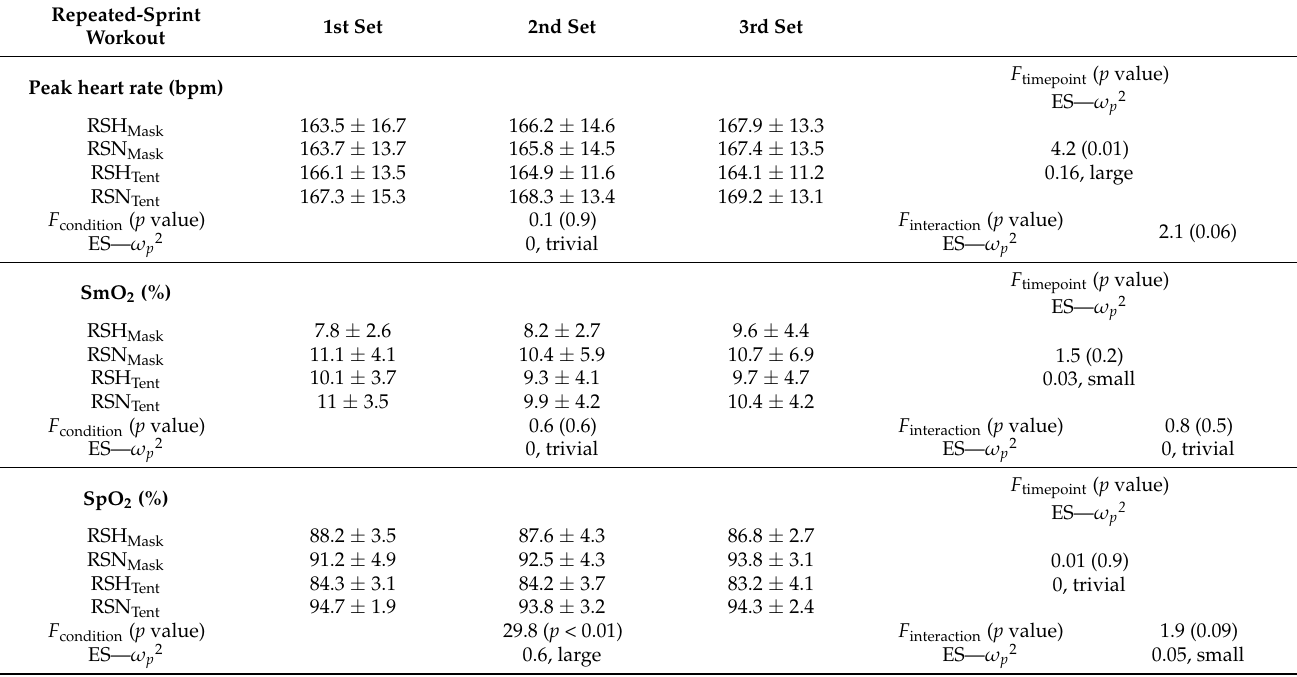
Table 1. Changes in cardiovascular responses due to repeated-sprint workout in normoxia and hypoxia. Repeated-Sprint Workout